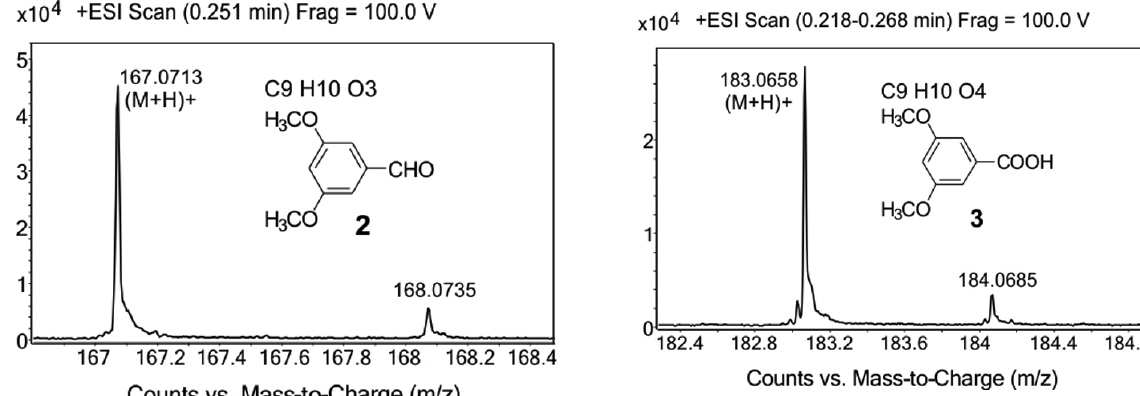
Figure 3. HRMS-ESI spectrum of the residue of 1f after irradiation showing characteristic signals of the main degradation products 2 and 3 .